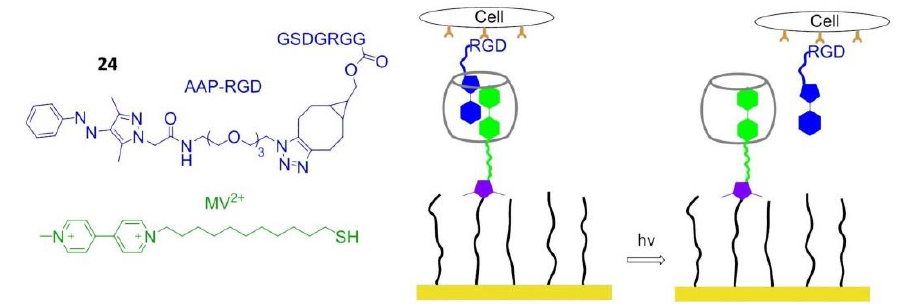
Figure 20. Photo-responsive polymers. AAP-RGD is isomerized from E- to Z-isomer under UV irradiation at 365 nm, resulting in dissociation of AAP-RGD from MV 2 + / AAP-RGD / CB[8] complex. When AAP-RGD is irradiated at 520 nm, the E-isomer is reobtained, and the MV 2 + / AAP-RGD / CB[8] complex can reform.